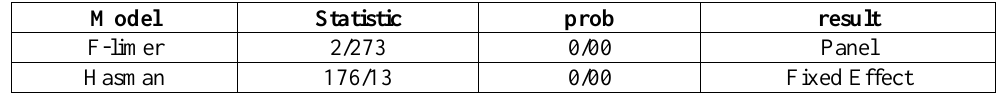
Table 2. The results of f-limer and hasman test